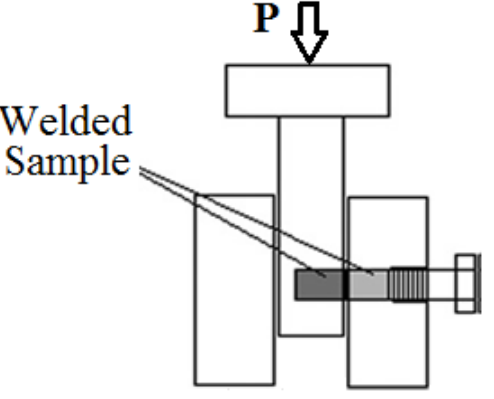
Figure 2. Schematic illustration of the shear test specimen holder.